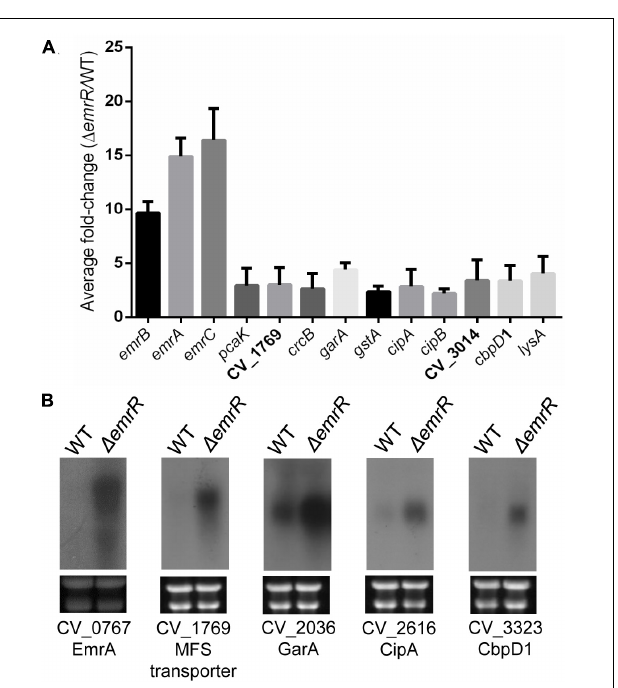
FIGURE 4 | The EmrR regulon includes mainly EmrR-repressed genes. (A) Data from DNA microarray analysis for selected EmrR-repressed genes are shown as average ratios with standard deviations from three biological replicates comparing transcriptome from C. violaceum ATCC 12472 with (cid:49) emrR mutant. For a complete list of the genes with altered expression levels, see Supplementary Table S4 . (B) Northern blot assays validated several genes as members of the EmrR regulon. Total RNA extracted from C. violaceum ATCC 12472 and (cid:49) emrR mutant were probed for the indicated genes. Levels of rRNA indicated equal RNA loading (bottom panels).